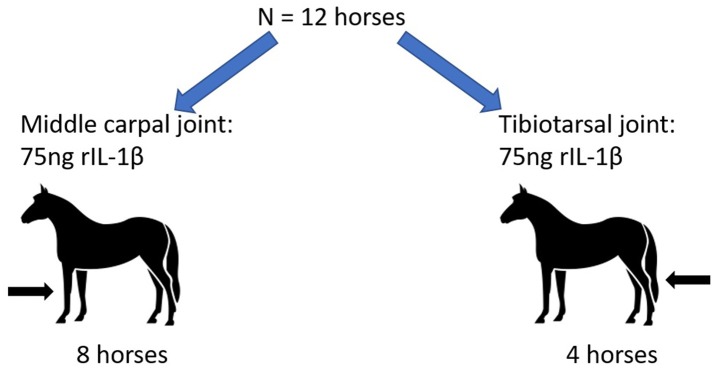
Experimental design. Twelve horses were enrolled in the study. Eight horses received 75 ng rIL-1β into the middle carpal joint. Four horses received 75 ng rIL-1β into the tibiotarsal joint. No other treatments were administered prior to or within 4 weeks following rIL-1β administration.